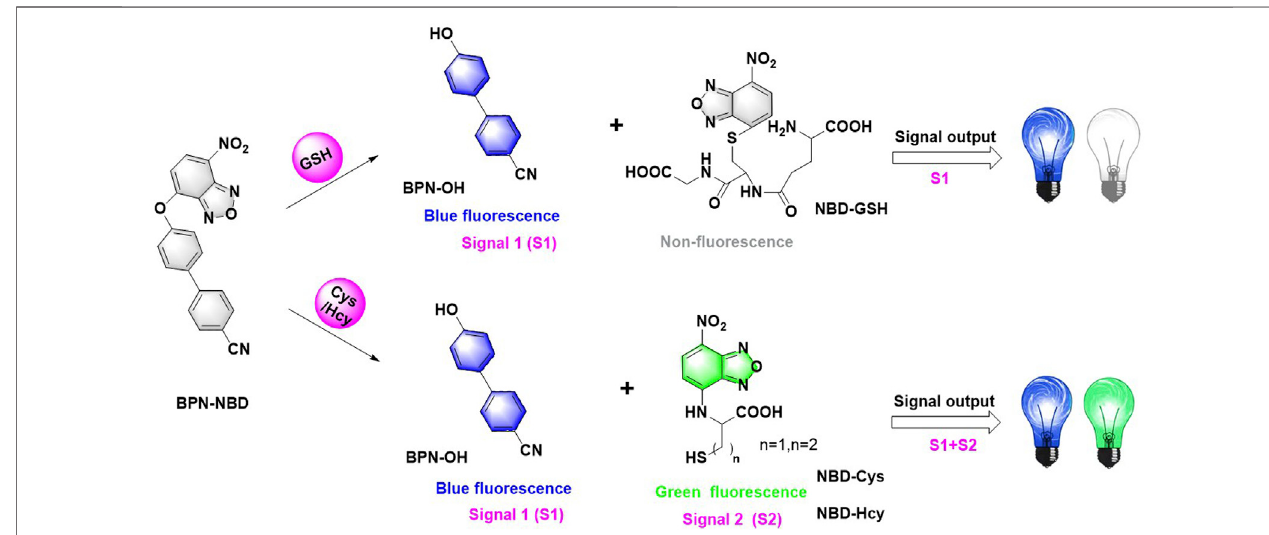
SCHEME 2 | The design strategy for